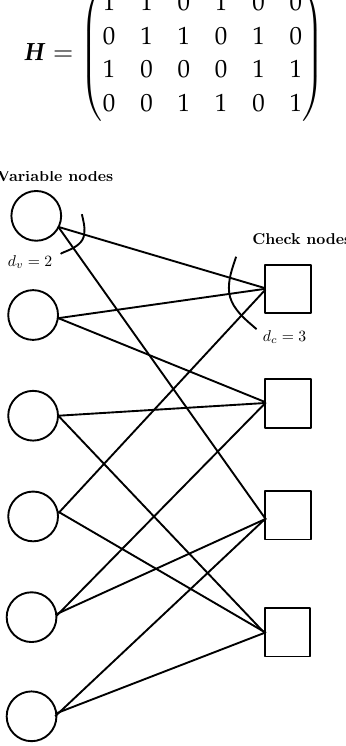
Figure 3. Factor graph of the Low-Density Parity Check (LDPC)